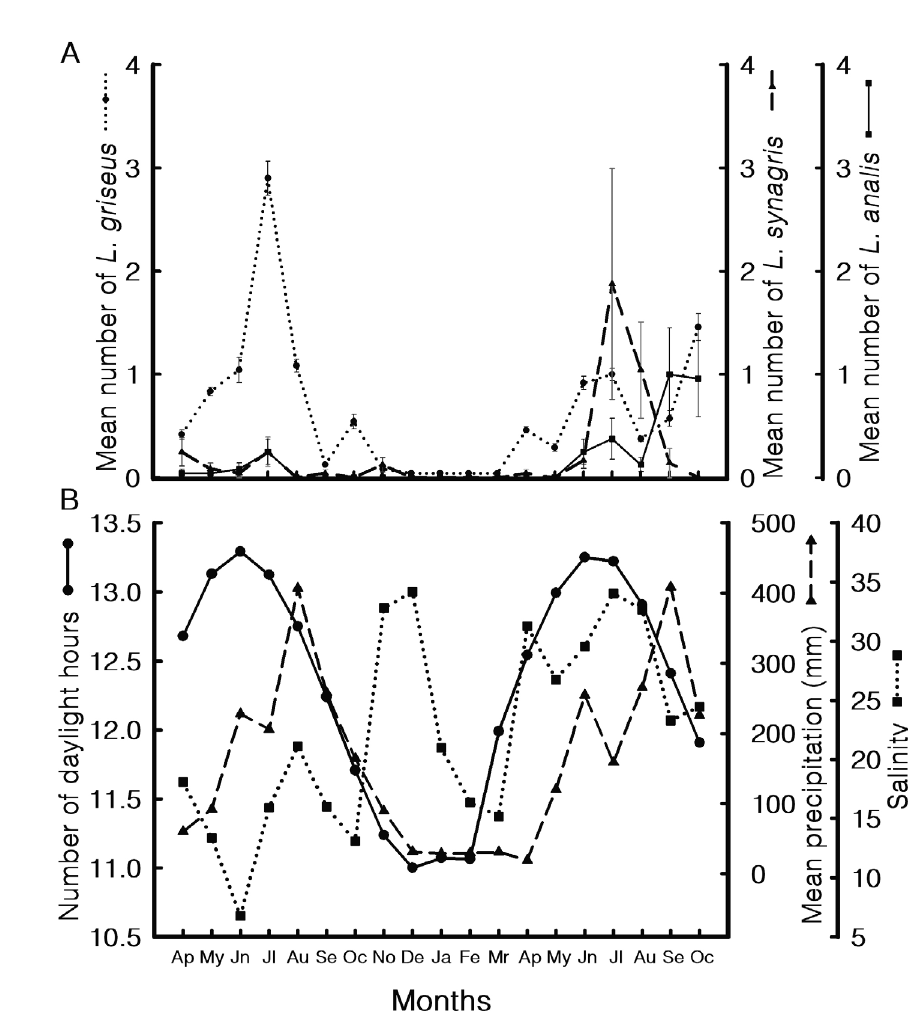
FIGURE 2 | Monthly variation of: A. Mean and standard error values of the three most abundant lutjanid species, and B. Values of the main environmental conditions studied in the study